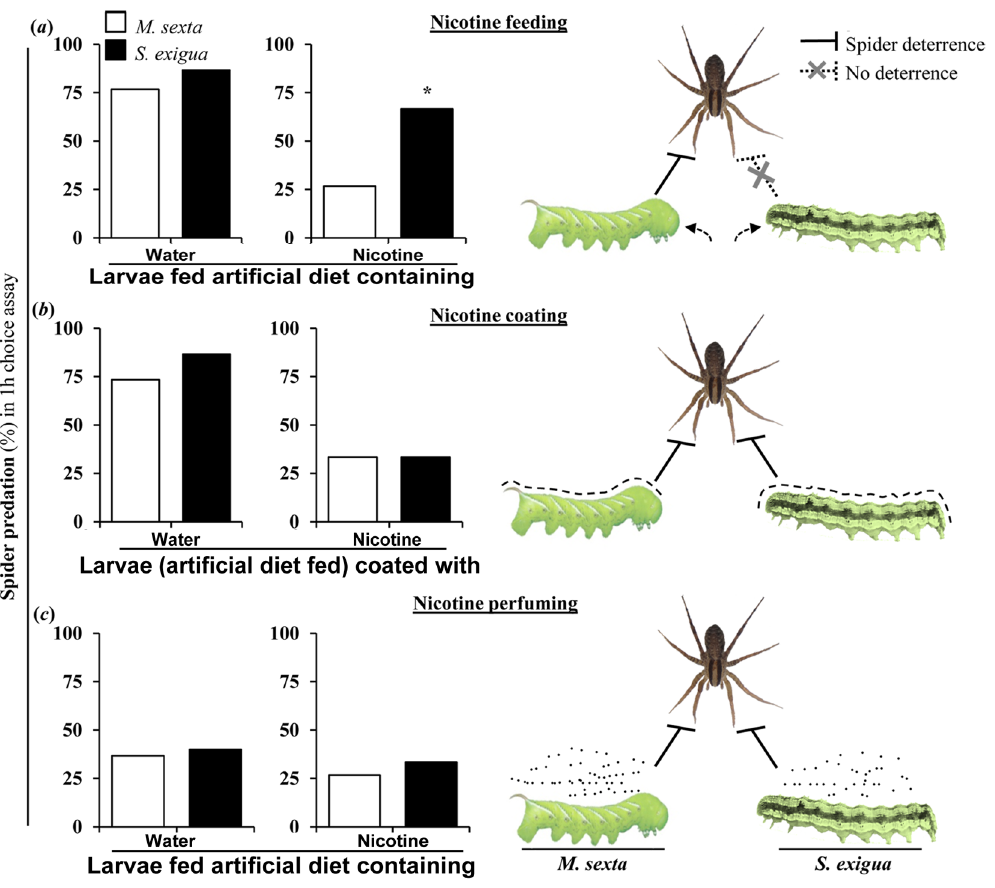
Figure 8. C.parallela ’s preference of S.exigua larvae over M.sexta larvae is diminished by topically coating larvae or supplementing their headspace with nicotine. C. parallela ’s predation (%) (in 1 h choice assay) on second-instar M. sexta and S. exigua larvae fed (a) artificial diet or artificial diet containing 0.1% (fresh mass) nicotine (b) artificial diet and coated with water (control) or nicotine, and (c) artificial diet containing water (control) or 0.1% (fresh mass) nicotine and having the assay environment nicotine-perfumed using 500 m L of 1 mM nicotine on a cotton swab. Schematics in right panels of (a), (b) and (c) show the effects of various modes of nicotine supplementation to M. sexta and S. exigua larvae on the spider predation behavior. Each bar represents data from 30 larvae. Asterisks indicate significant differences ( P # 0.05) in frequencies (and displayed percentages) by Fisher’s exact test.